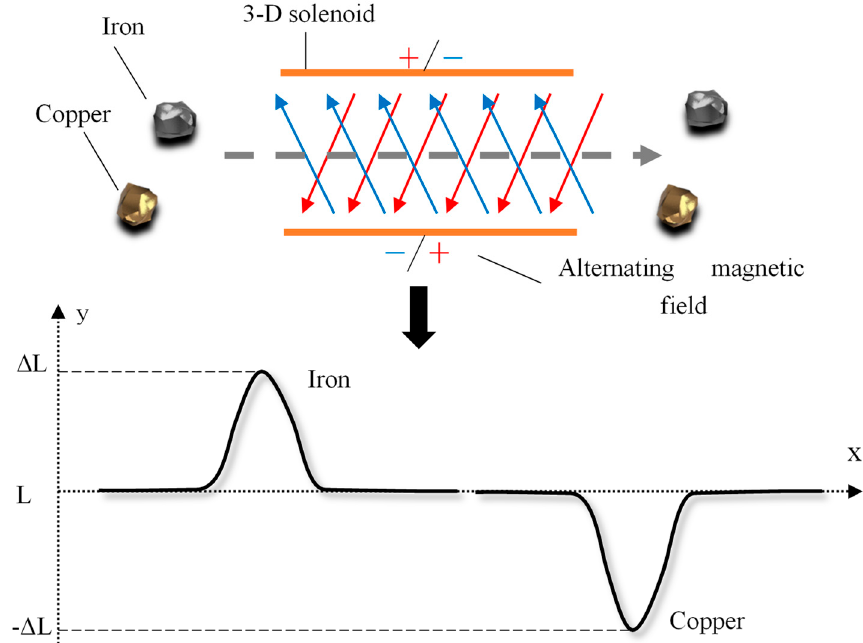
Figure 3. A 3-D solenoid coil detection principle diagram: When iron particles flow through the magnetic field area, ∆ L > 0, the detection signal direction is upward, and when copper particles flow through the magnetic field area, ∆ L < 0, the detection signal is downward.